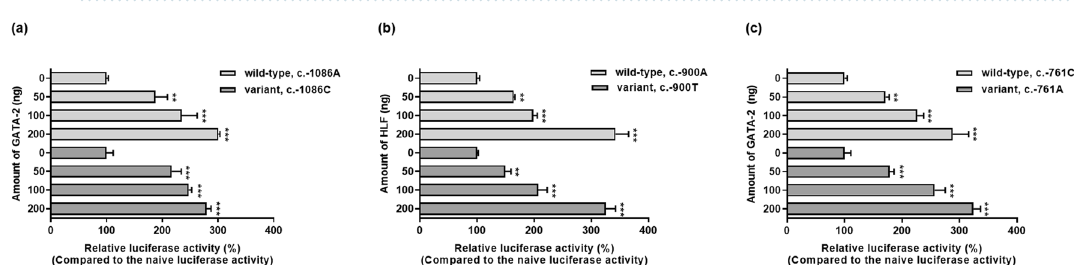
Figure 6. Effect of transcription factors on ABCA4 promoter activity. Luciferase activity was measured 48 h after co-transfection of wild-type ABCA4 or its variant reporter plasmids and varying amounts of GATA-2 (a and c) or HLF cDNA (b) . The reporter activity of each construct was compared with naïve luciferase activity. The data (mean ± SD) represent triplicate measurements in a representative experiment. ** P < 0.01, *** P < 0.001 versus naïve luciferase